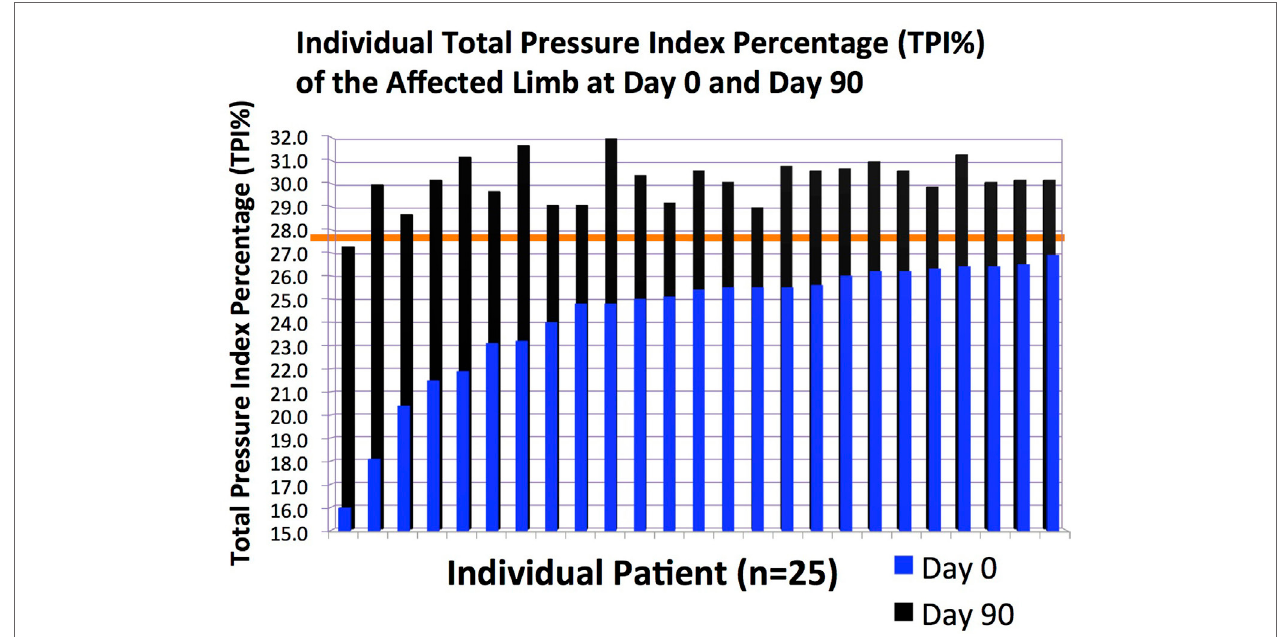
FigUre 9 | The individual cross-sectional area (csa) of the affected supraspinatus tendon at days 0 and 90 and unaffected supraspinatus tendon